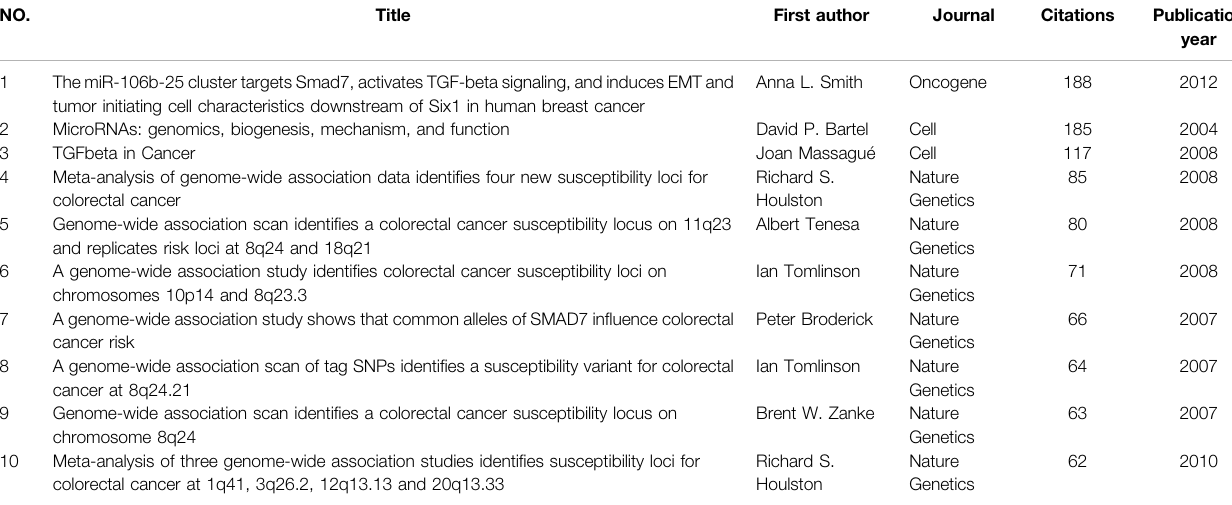
TABLE 7 | Top 10 highly co-citation of cited references on SMAD7 in the fi eld of oncology.